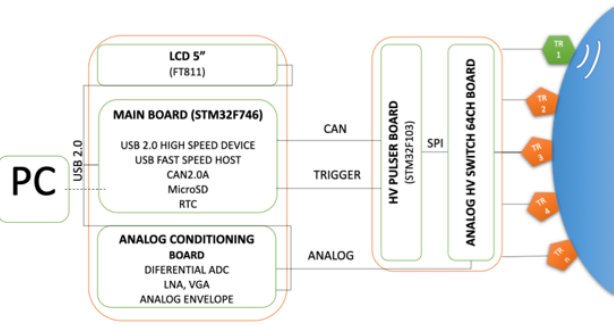
Figure 2. The schematic view of the ultrasound reflective tomograph.